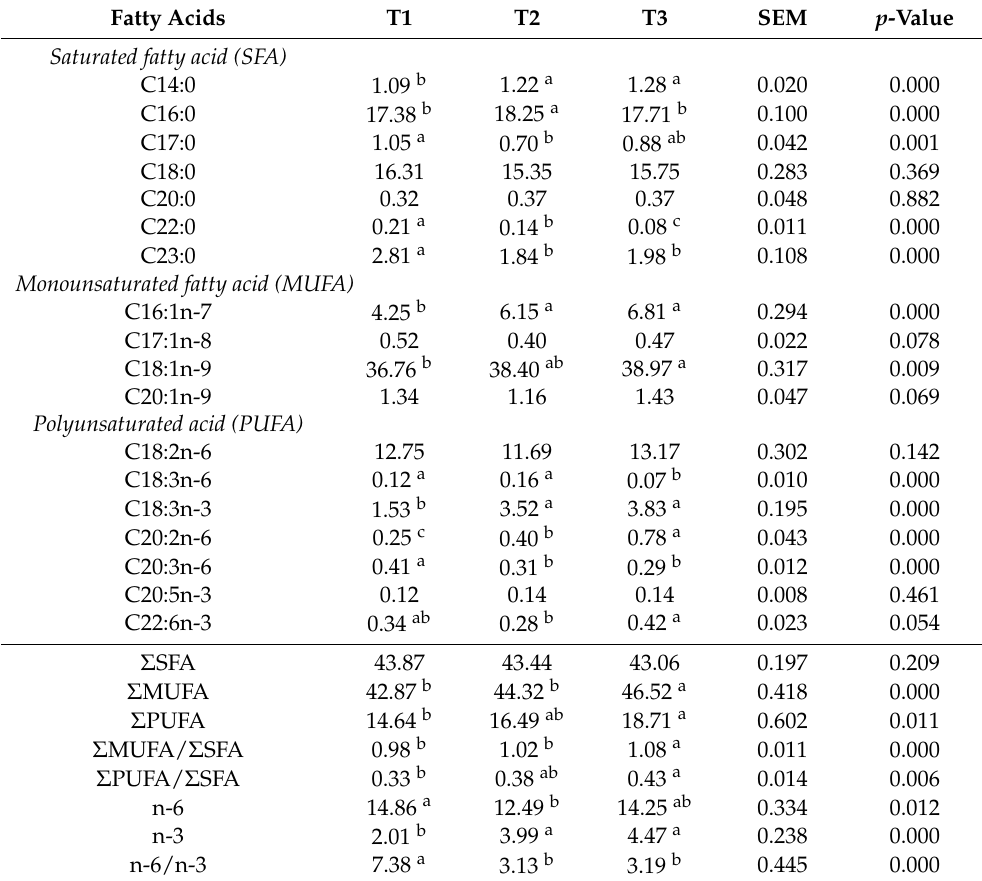
Table 7. Fatty acid composition of longissimus thoracis et lumborum muscle from finishing crossbred pigs fed a low-lysine diet supplemented with perilla cake (g/100 g of total fatty acids). Fatty